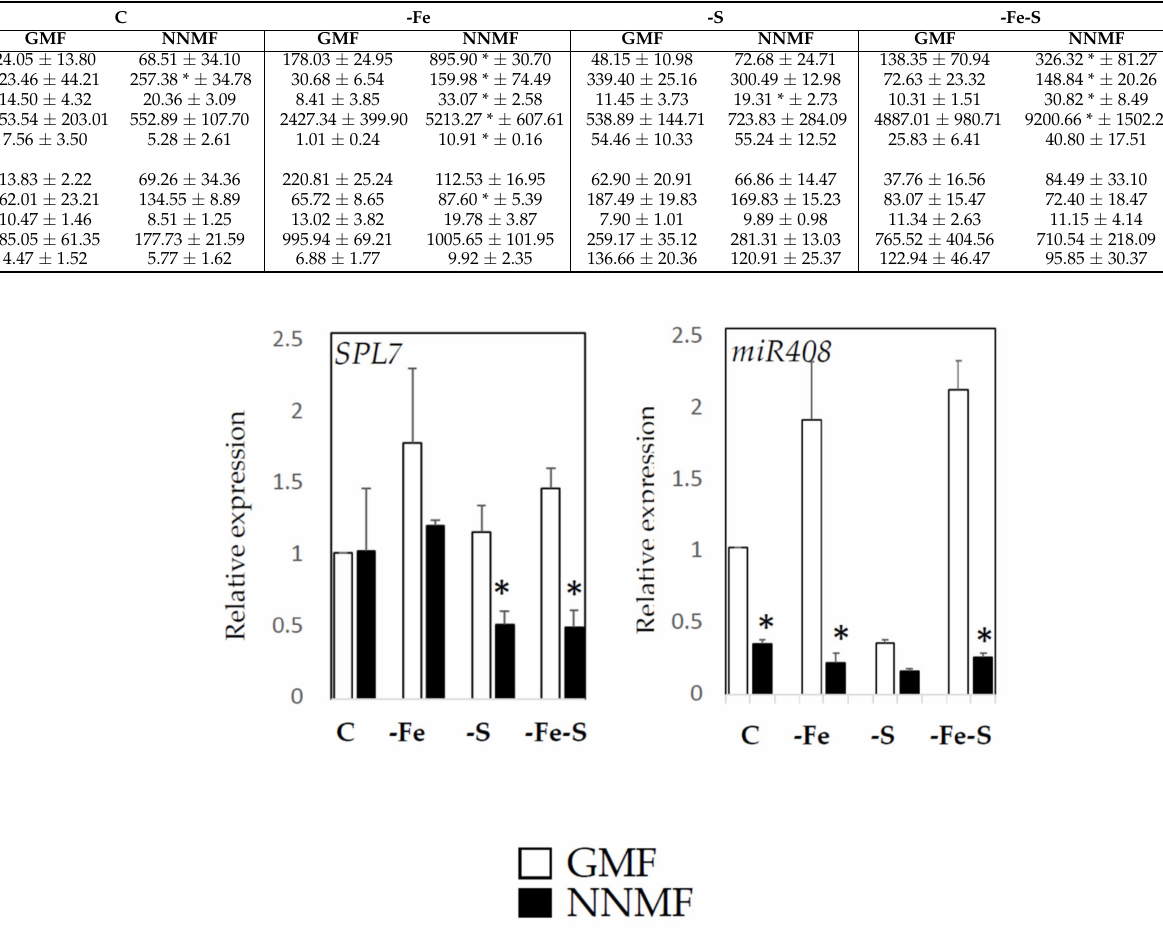
Figure 4. Expression of gene regulation Cu homeostasis (SPL7 and miR408) in Arabidopsis thaliana seedlings grown under full nutrient conditions (C), absence of iron (-Fe), absence of sulfur (-S) and combined Fe and S deficiency (-Fe-S). Plants were exposed for 7 days both to GMF and NNMF conditions. Data are from three independent experiments ( n = 3). Values are expressed as fold changes ( ± SE) with respect to control plants growing in GMF conditions under full nutrient media (C). Asterisks indicate significant ( p < 0.05) differences between NNMF and GMF exposed plants. Two-way ANOVA results are reported in Table